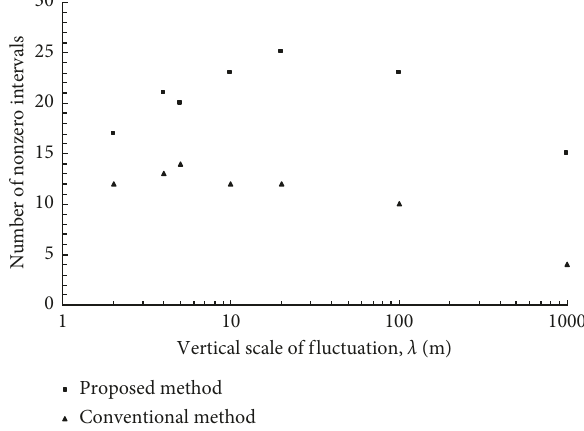
Figure 12: Variation of nonzero intervals with λ of S cohesive